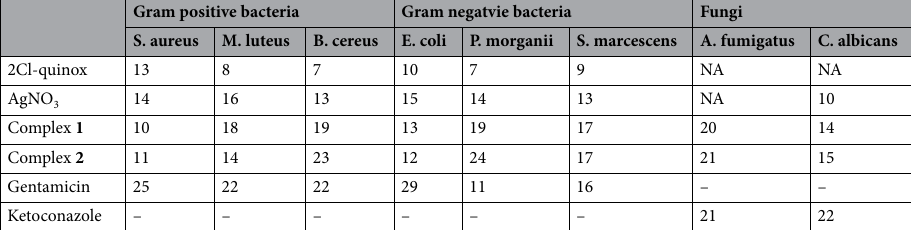
Table 2. Diameters of inhibition zone (mm) of the tested compounds against different species of microorganisms.